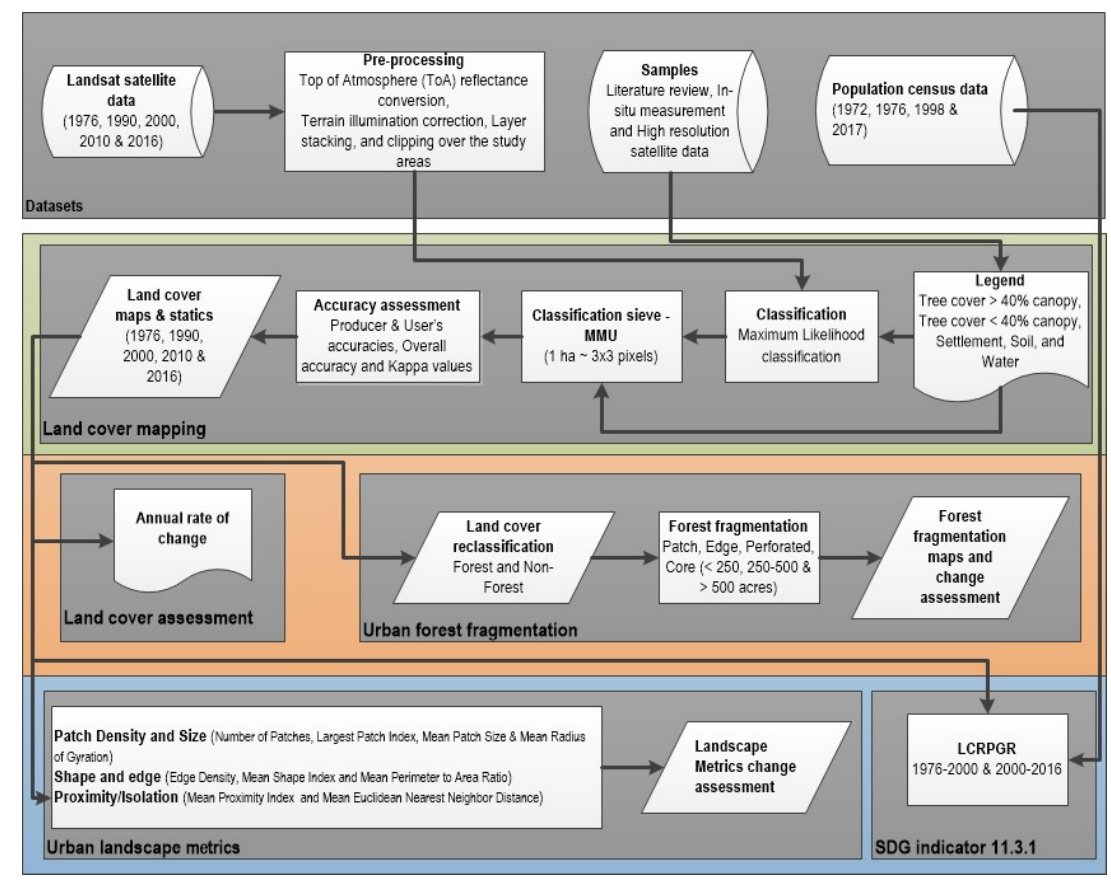
Figure 2. Methodological flow chart.